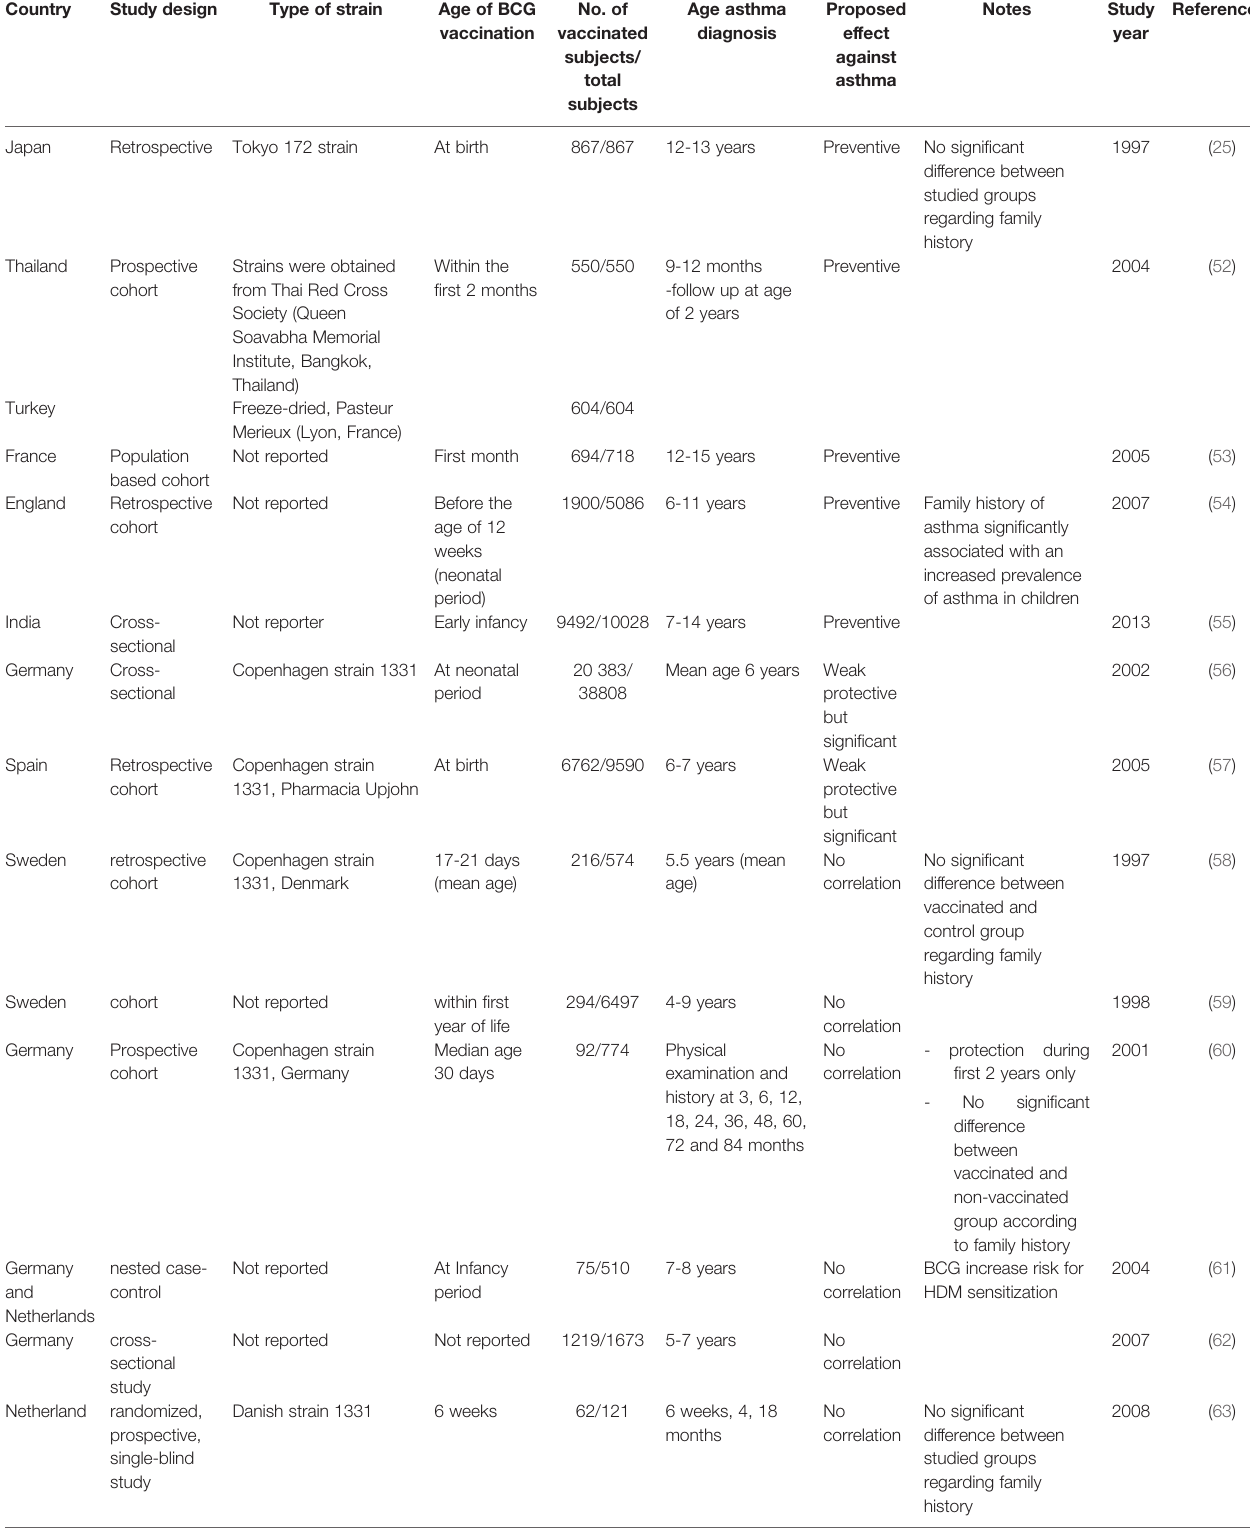
TABLE 2 | Impact of BCG vaccination on human allergic asthma.